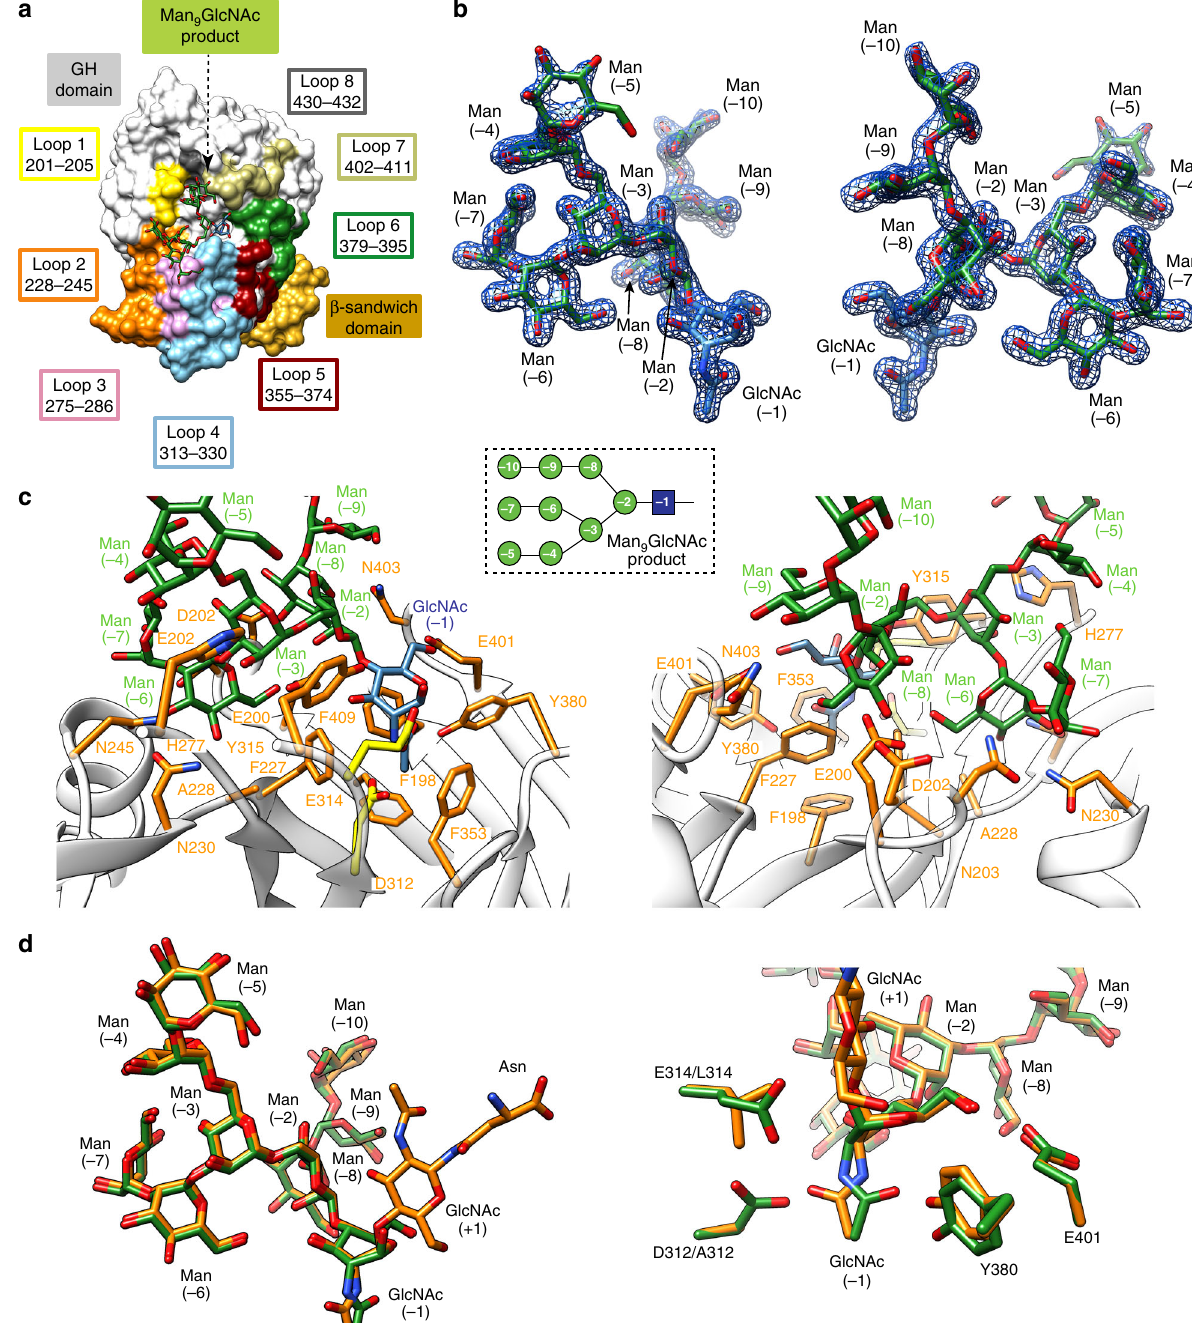
Fig. 3 The product Man 9 glycan binding site. a Surface representation with annotated domains and GH loops of the EndoBT-3987 WT -Man 9 GlcNAc-2 crystal structure. b Two views of the electron density of Man 9 GlcNAc product shown at 1.0 σ r.m.s deviation. c Two views of the key residues of EndoBT- 3987 interacting with Man 9 GlcNAc product are colored in orange. The catalytic residues are colored in yellow (D312 and E314). d Two views of superposition of Man 9 GlcNAc 2 Asn substrate (orange) and Man 9 GlcNAc product